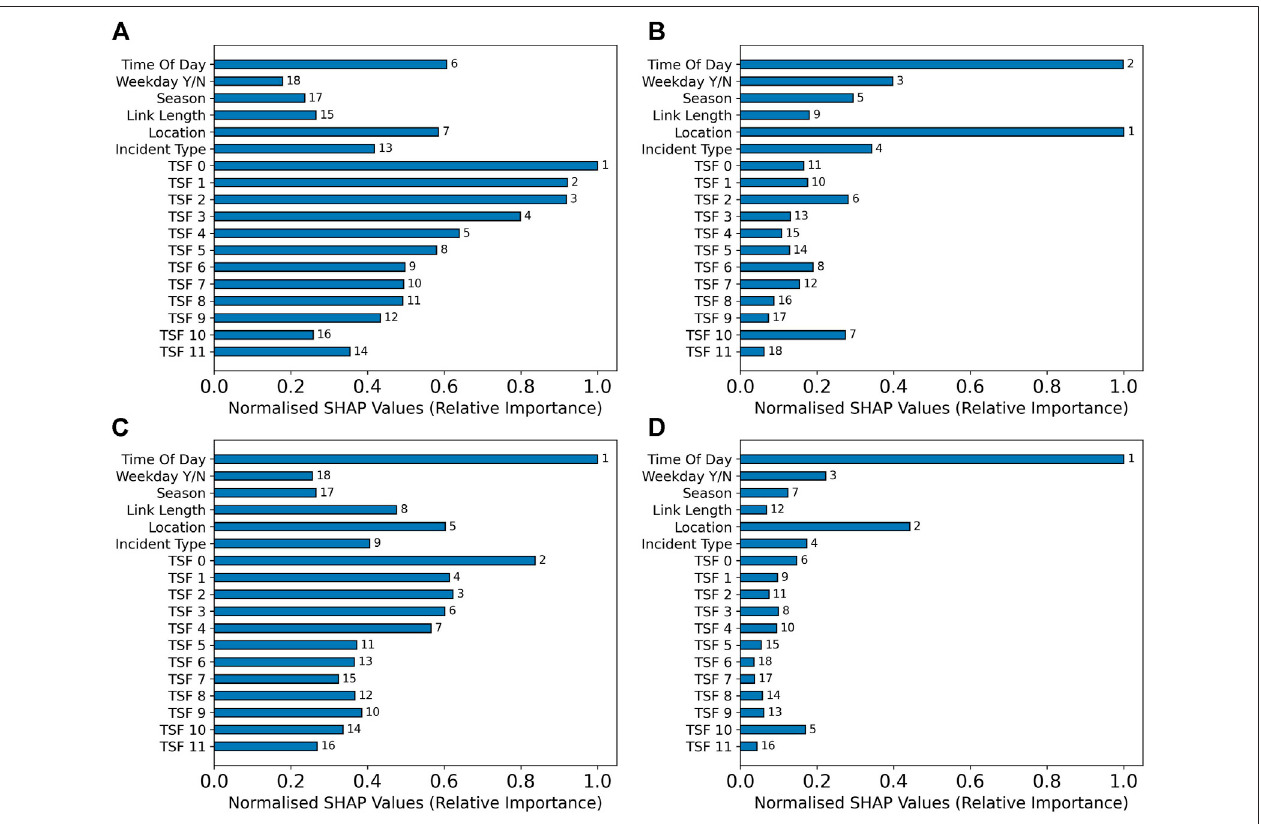
FIGURE 5 | Variable importance, as measured for the sliding window neural network model, for a subset of the important variables. Each plot is a different predictionhorizon,allshownareatapredictiontimeof t (cid:2) 30.TheimportanceateachpredictiontimeiscomputedbytakingtheaverageoftheabsoluteSHAPvaluesfor each feature across all query instances, and then has been normalized such that the largest importance at any horizon is 1, and all others are relative to this. The rank of each variable at a given time is written beside each bar. Due to the scaling, one should focus on the ranking and relative difference between bars in each plot. TSF stands for time-series feature, that have been extracted through passing temporal convolutions across the data. (A) : h (cid:2) 5. (B) : h (cid:2) 30. (C) : h (cid:2) 60. (D) : h (cid:2)